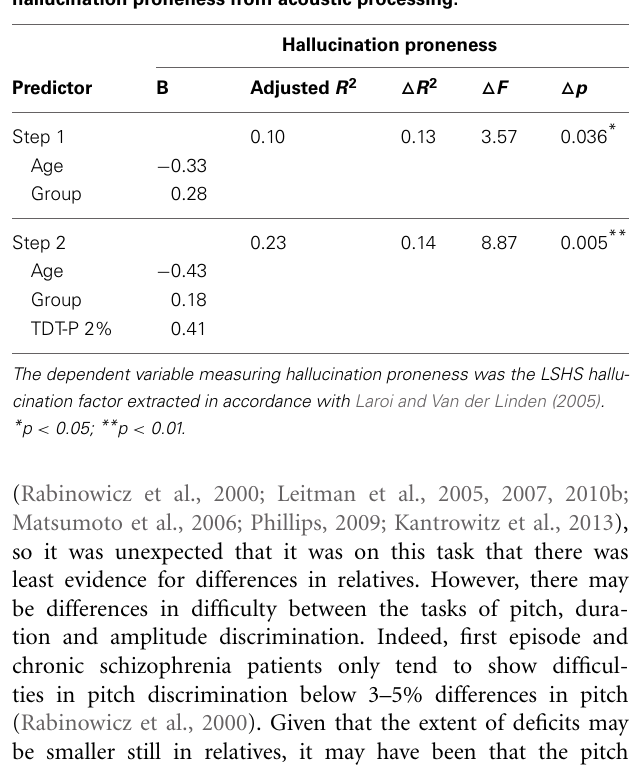
Table 5 | Hierarchical multiple regression analysis predicting hallucination proneness from acoustic